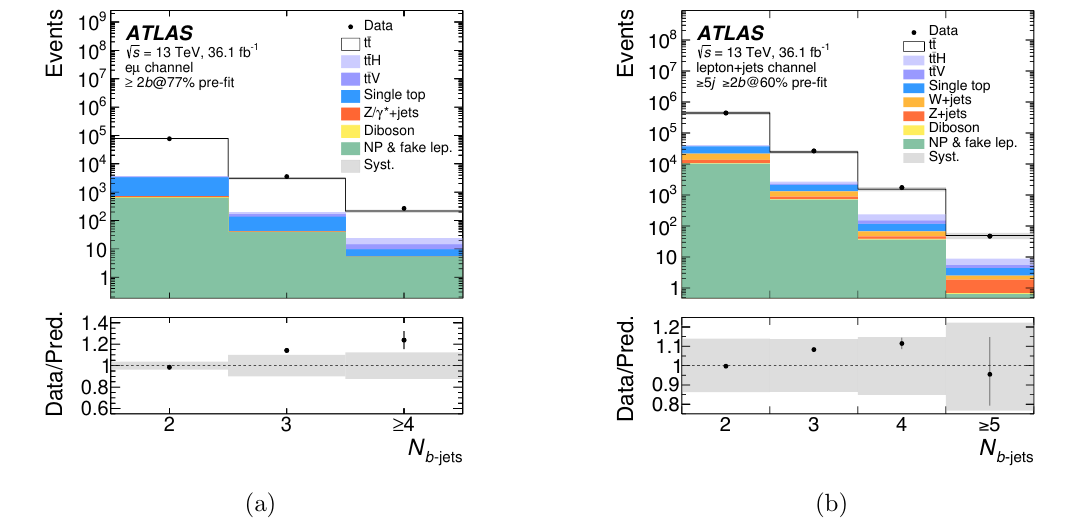
Figure 2. Comparison of the data distributions with predictions for the number of b -tagged jets, in events with at least 2 b -tagged jets, in the (a) e(cid:22) and (b) lepton + jets channels. The systematic uncertainty band, shown in grey, includes all uncertainties from experimental sources.